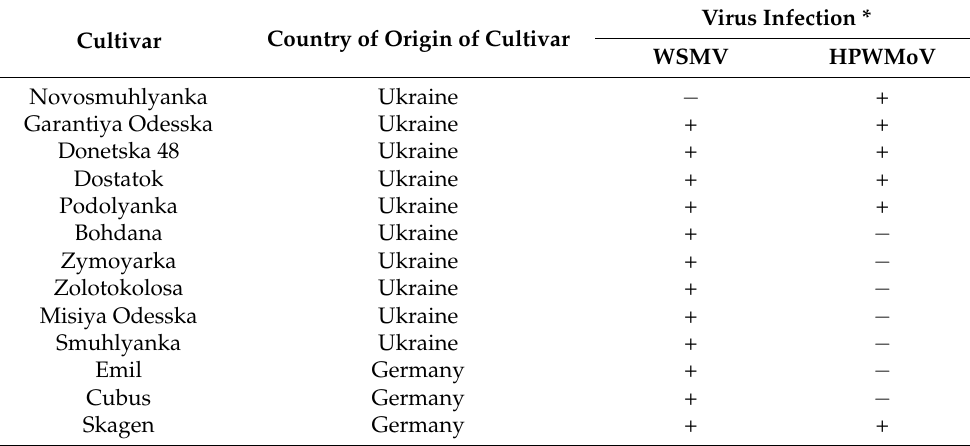
Table 3. Occurrence of natural infection of WSMV and HPWMoV in Ukrainian and German varieties of winter wheat cultivated in Ukraine.